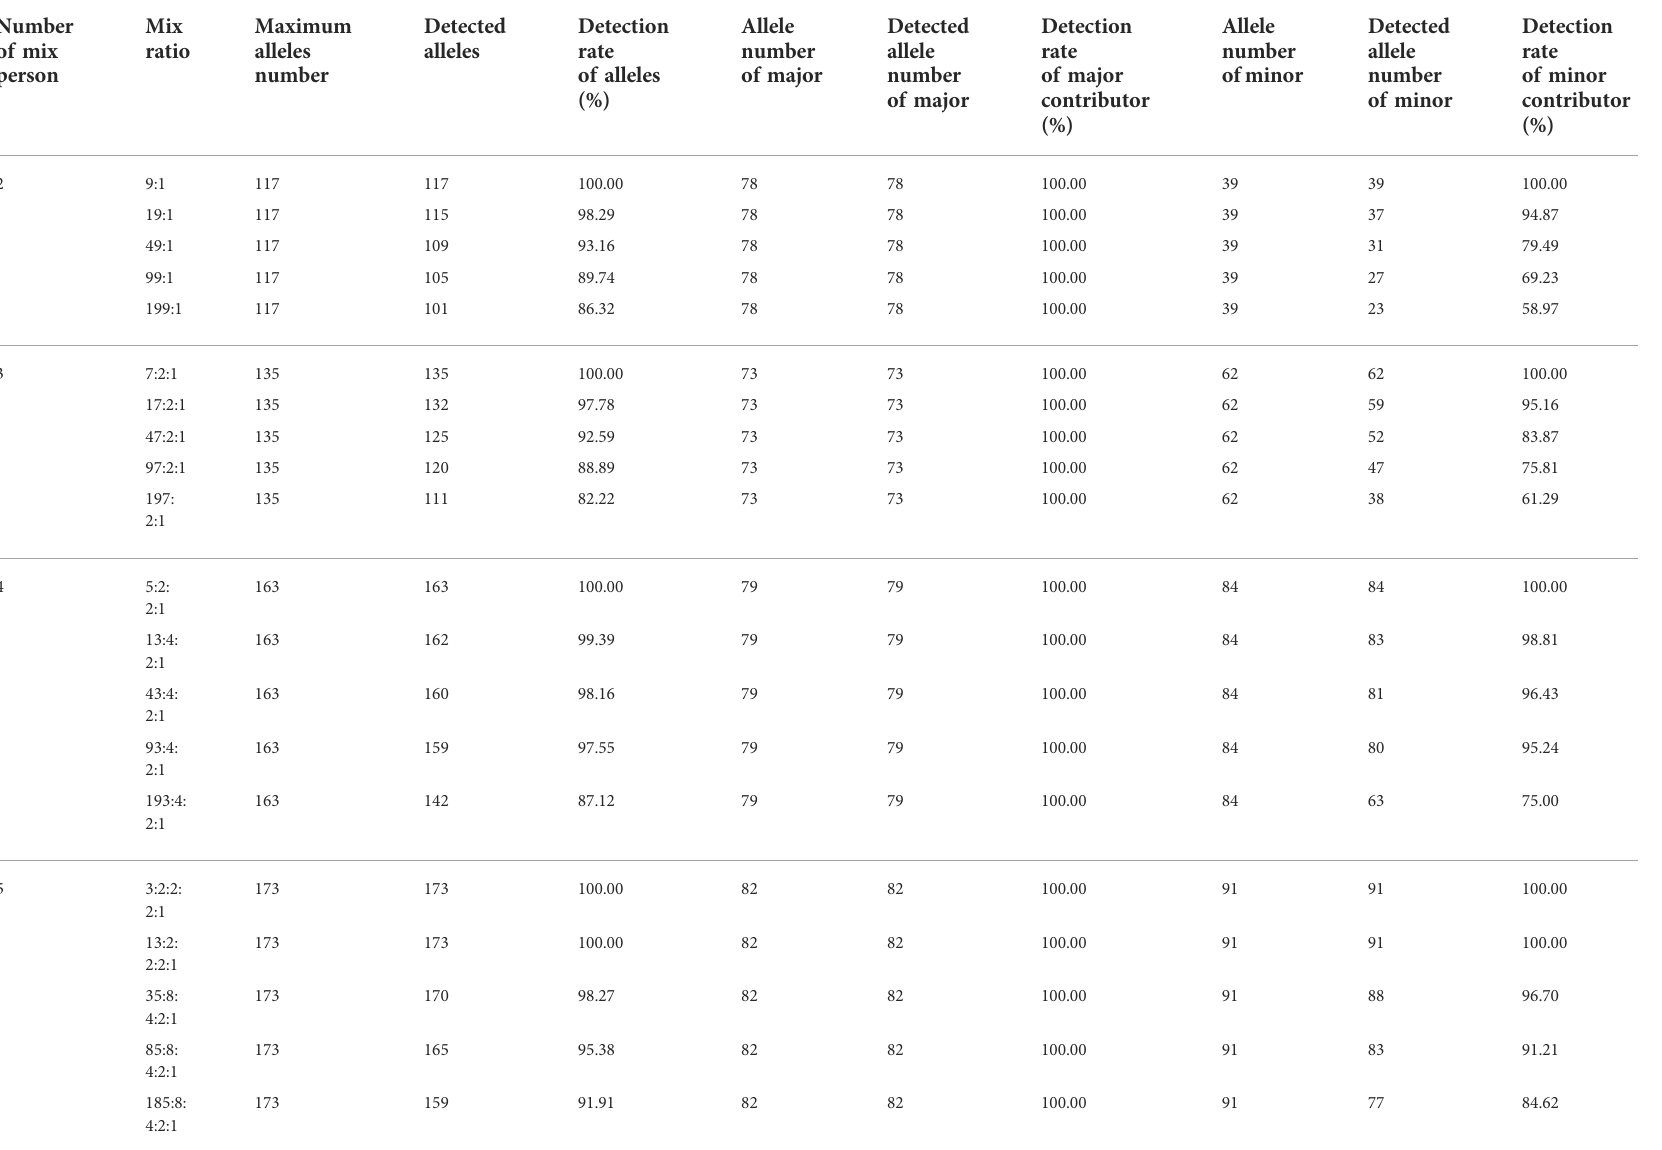
TABLE 3 NGS-MH analysis results of the DNA mixtures. Number of mix